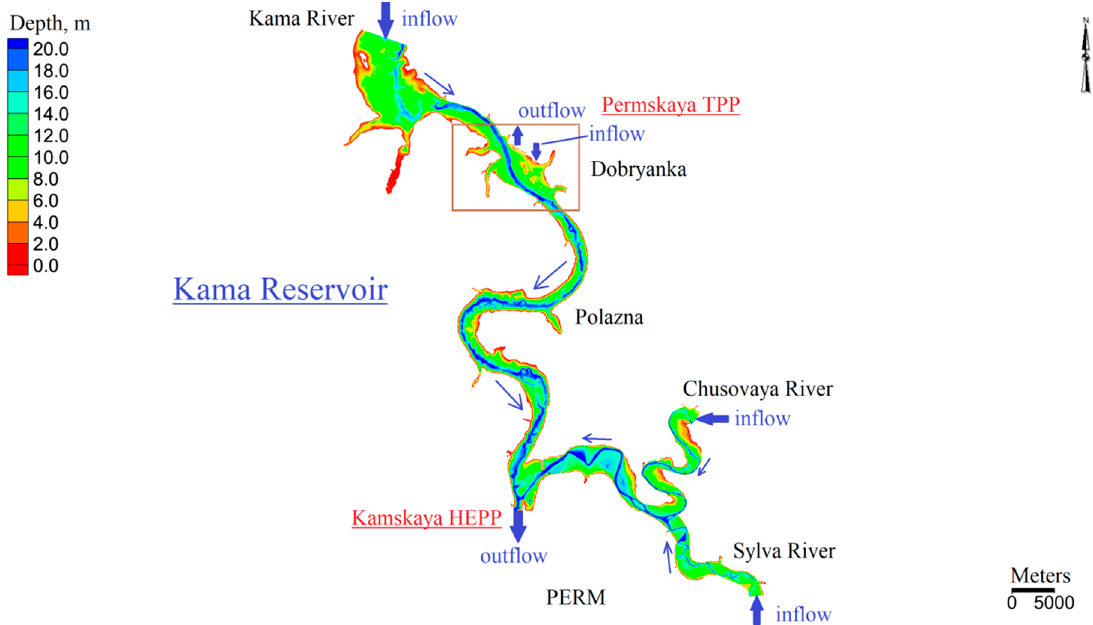
Figure 1. Morphometry of the considered section of the Kama reservoir. The brown rectangle shows the area of interest in the vicinity of Dobryanka town.